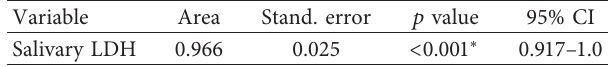
Table 3: Area under the curve for salivary LDH as a predictor of HIE.